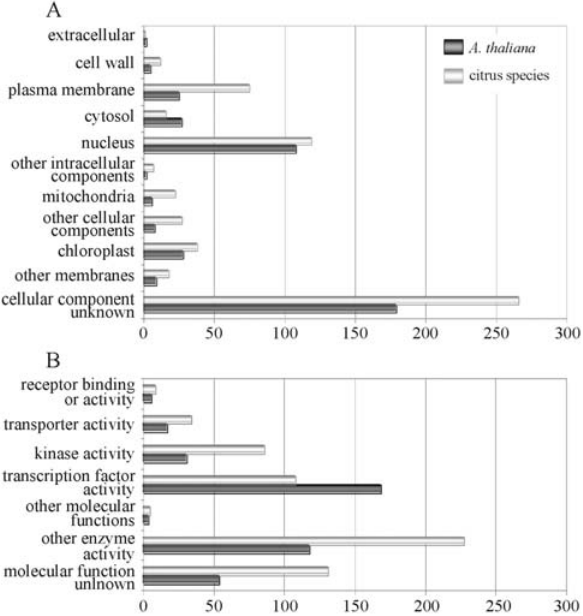
Figure 1 - Comparison between the functional classification of citrus transcripts and Arabidopsis proteome associated to phytohormone metab- olism and signaling pathways using gene ontology. A. cellular compo- nent; B. molecular function. The normalized number of genes is represented on the x-axis. Assignments are based on the data available at the TIGR Arabidopsis thaliana Gene Index version